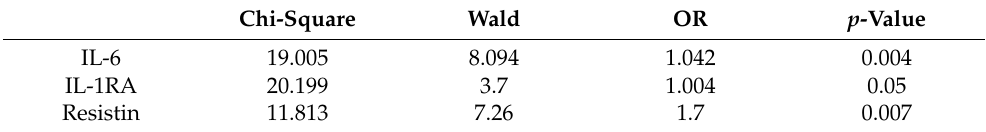
Table 4. Univariate binary logistic regression for cytokines to assess the ability to predict LVR. Chi-Square Wald OR p -Value IL-6 Resistin 11.813